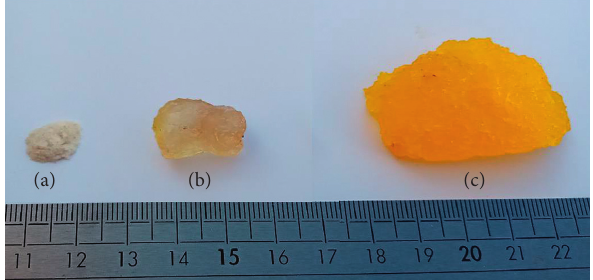
Figure 11: Image of dry TG powder (a), the swollen form of TG